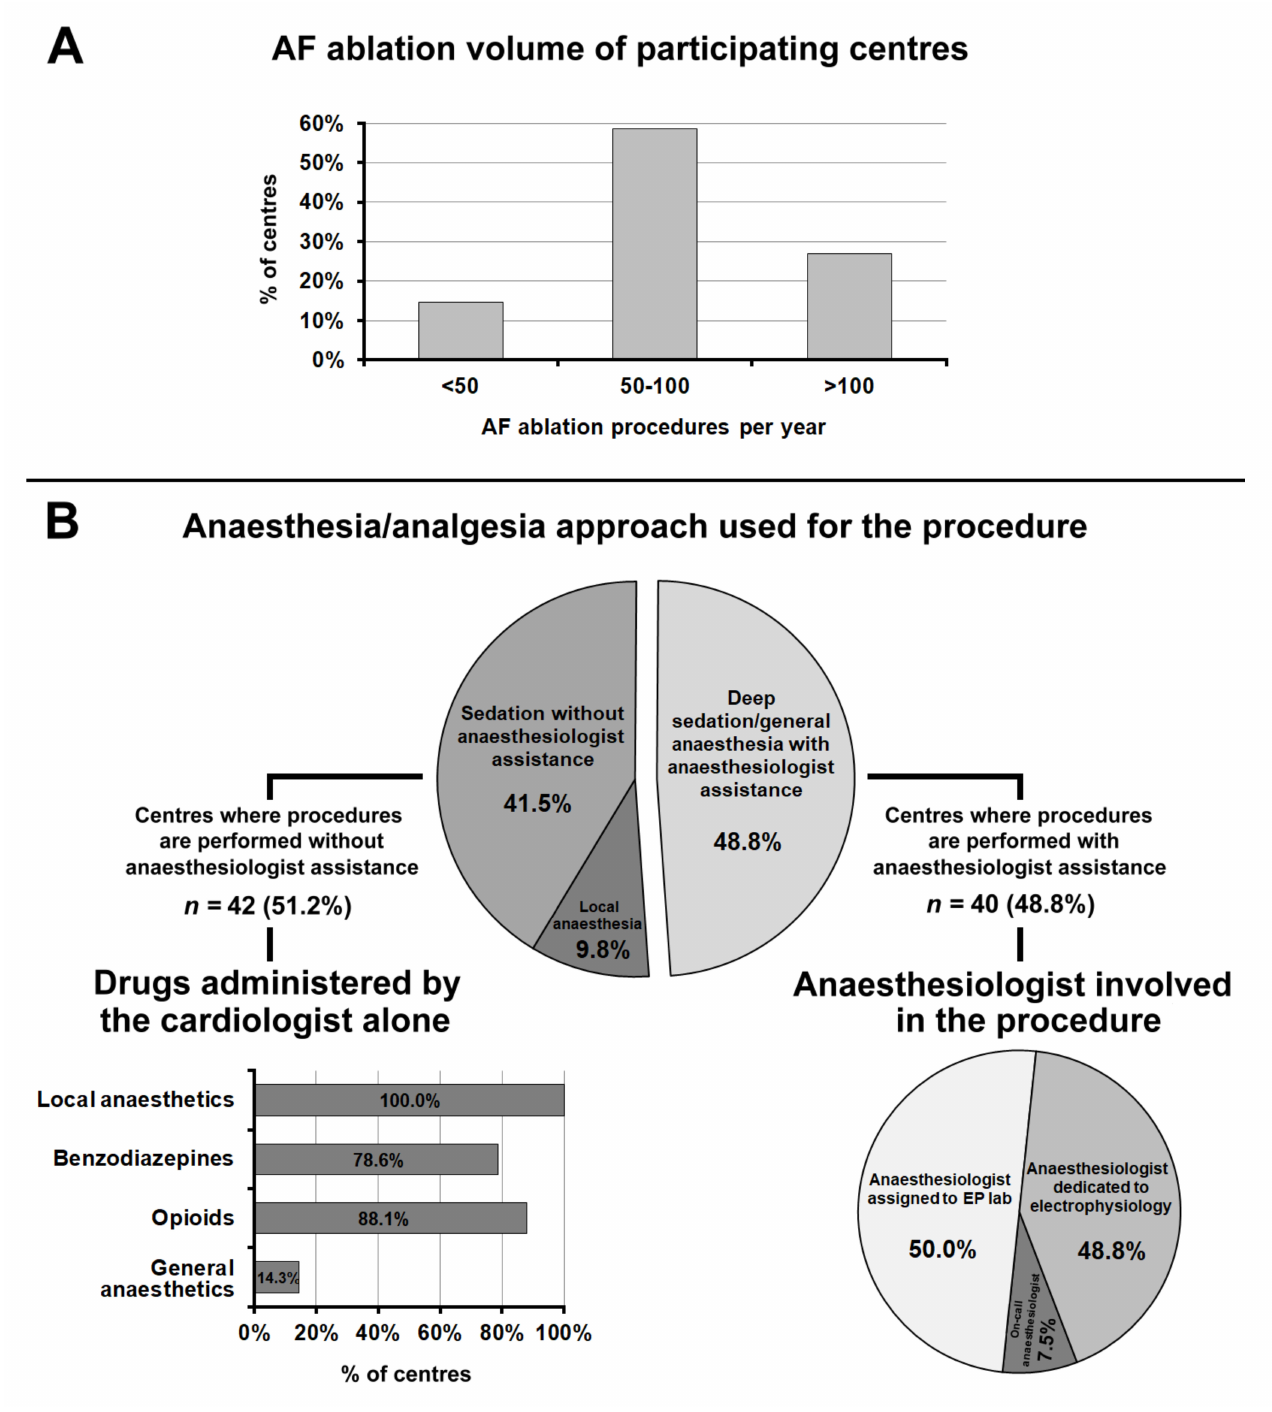
Figure 4. ( Panel A ): Atrial fibrillation ablation procedure volumes of participating centres. ( Panel B ): Anaesthesia/analgesia approach used for the procedure. Abbreviations used in the figure. AF: atrial fibrillation; EP lab: electrophysiology